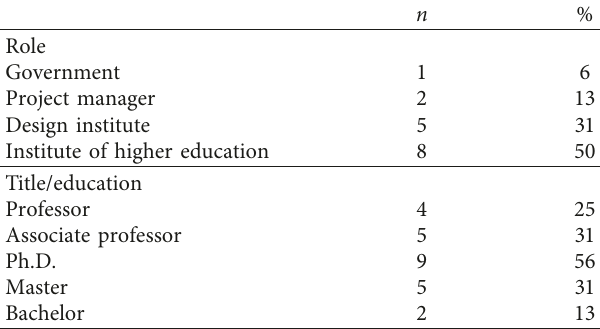
Table 3: Information of experts.